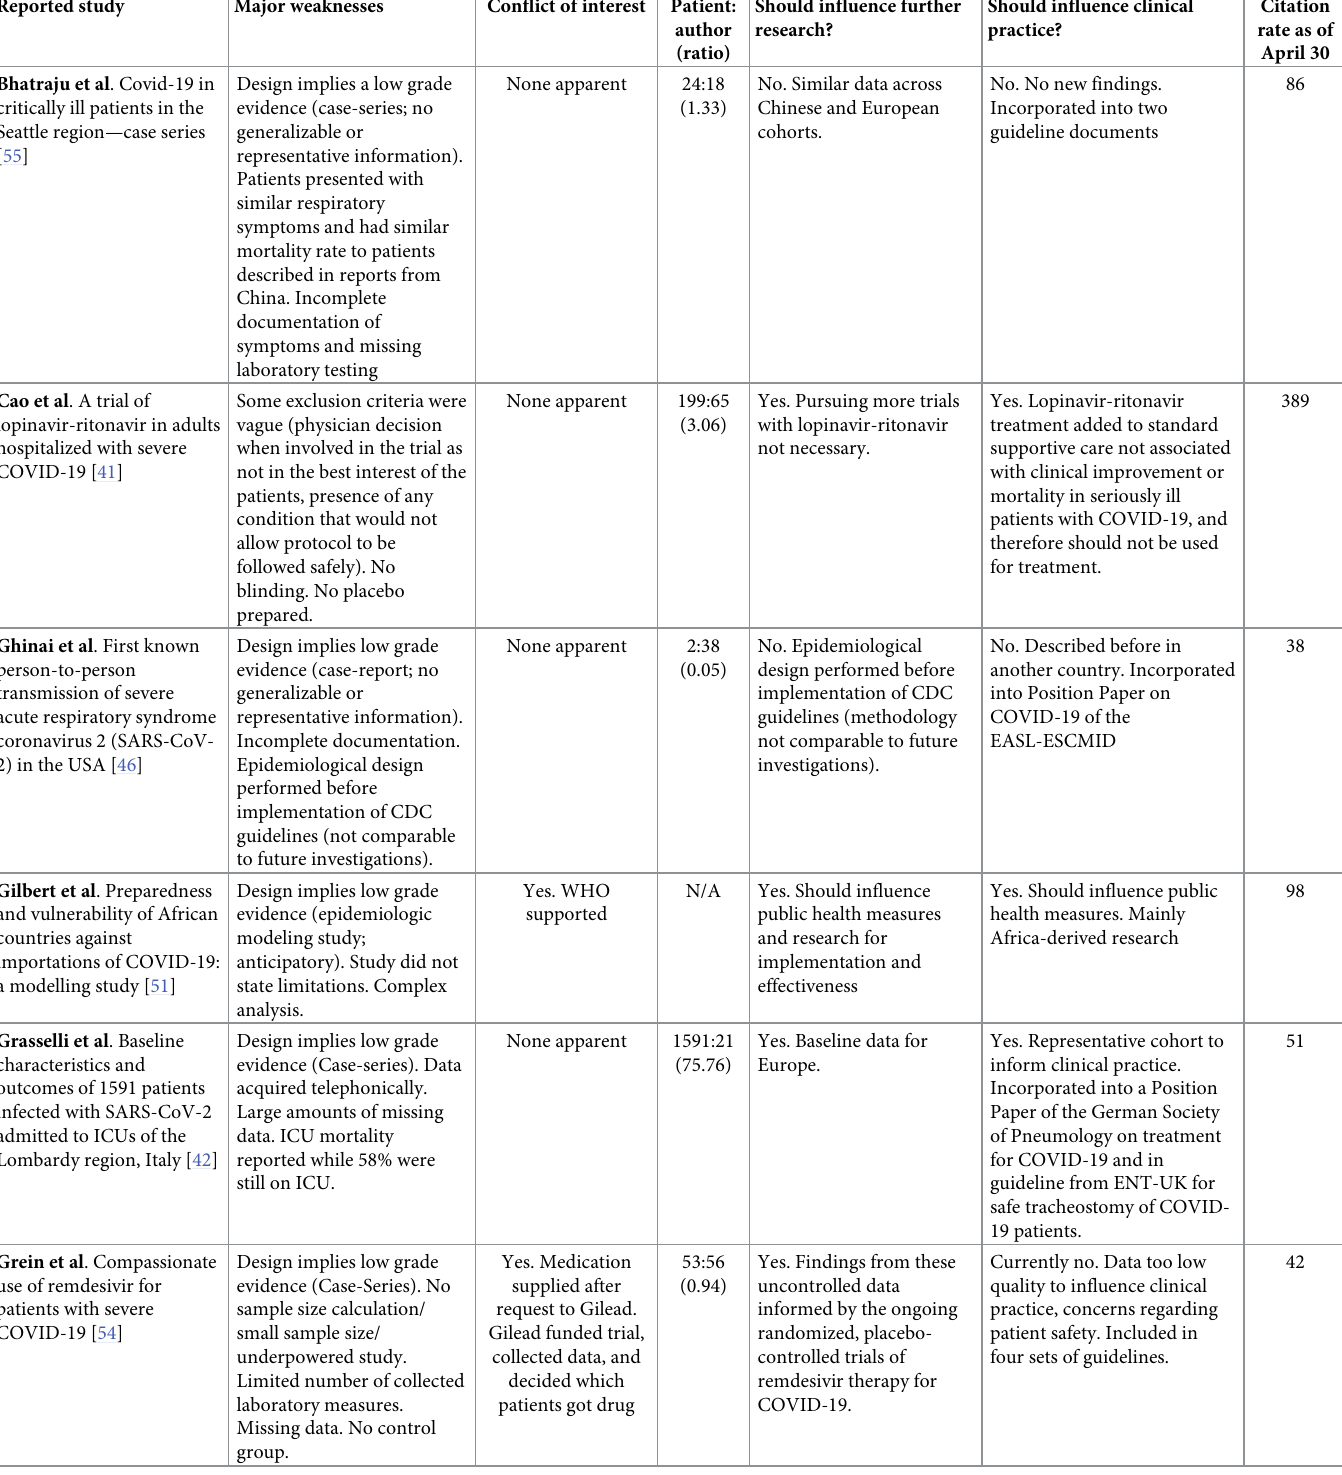
Table 4. Narrative assessment of the quality of the COVID-19 original